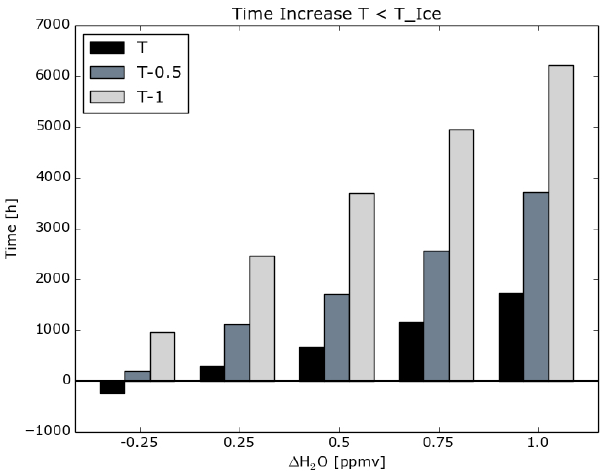
Figure 10. Histogram of increase in time where the temperature along the back trajectory is below the ice formation threshold tem- perature (sum over all 738 back trajectories) for a stratospheric H 2 O increase of 0.25, 0.5, 0.75 and 1.0ppmv, respectively, and for a stratospheric H 2 O decrease of